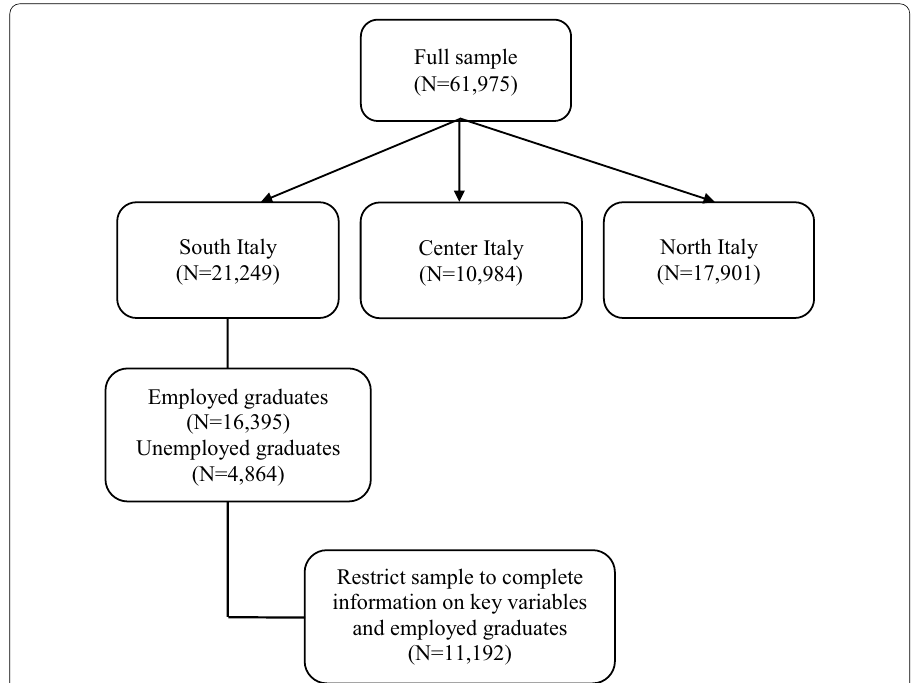
Fig. 6 Sample restriction. Source: AlmaLaurea (2010 graduate cohort); author